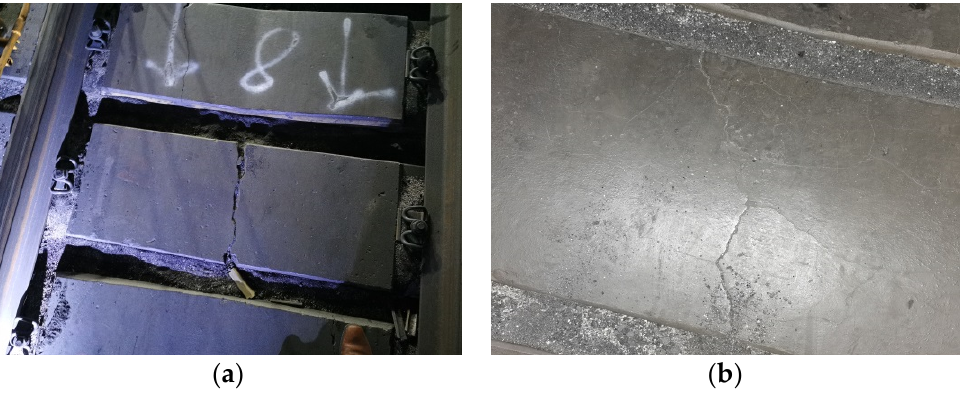
Figure 1. Examples of sleeper cracks. ( a ) sleeper crack-1. ( b ) sleeper crack-2.